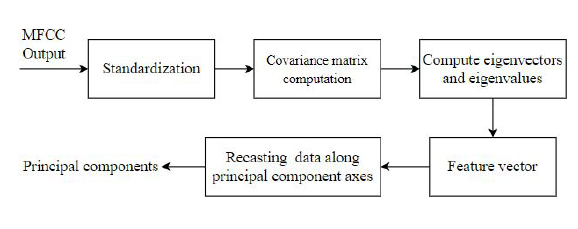
Figure 3. Steps involved in PCA